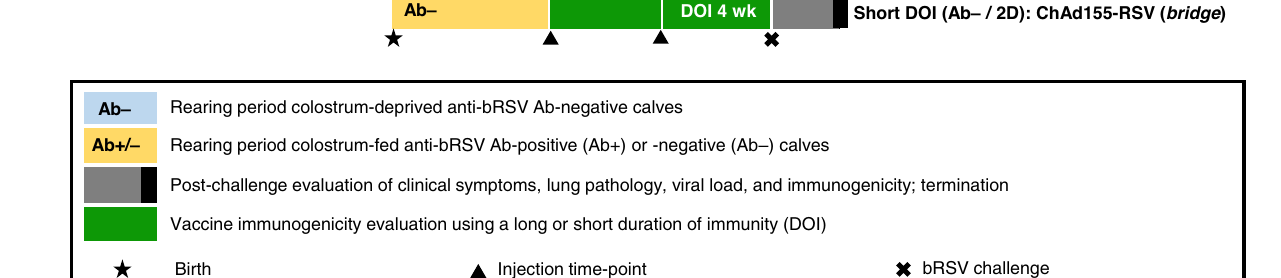
Fig. 1 | Study designs. Study 1 was conducted in bovine RSV (bRSV)-seronegative (Ab − ) colostrum-deprived calves. Study 2 was conducted in Ab − calves fed bRSV antibody-negative colostrum, and in bRSV-seropositive (Ab+) calves fed Ab-positive colostrum. Animals ( n =7 to 9/group) received 1 or 2 doses (1D or 2D, respectively)ofeitherChAd155-RSVvaccineorplacebo(phosphate-bufferedsaline;